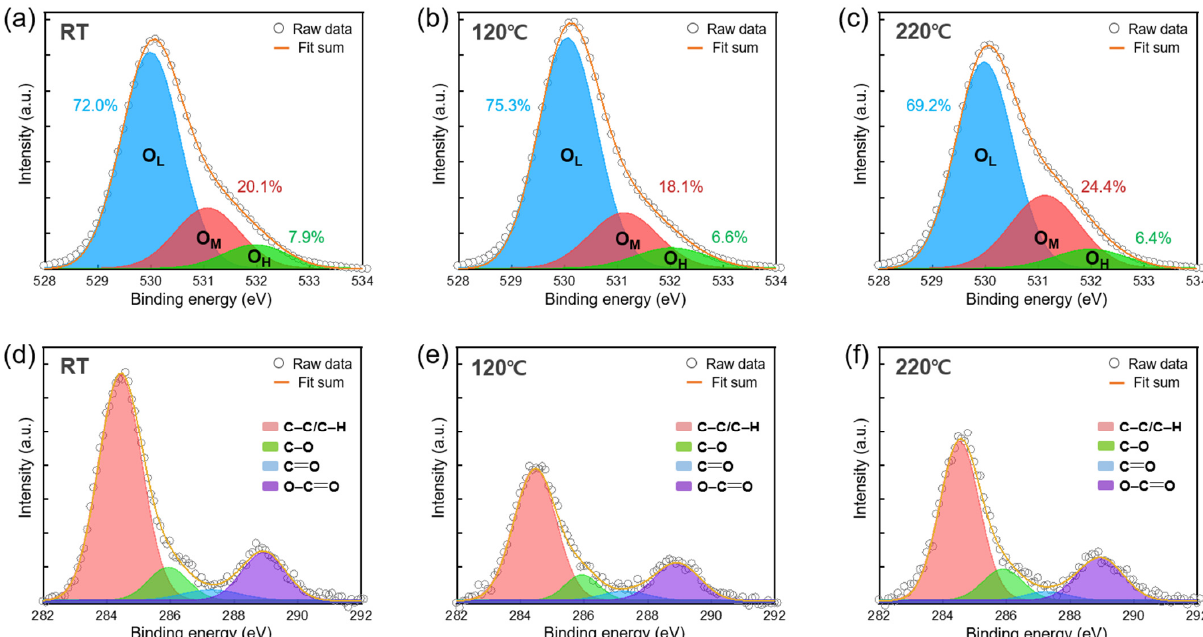
Figure 3. XPS O 1s peaks for the ZTO thin film pre–annealed at ( a ) RT, ( b ) 120 °C, and ( c ) 220 °C. XPS C 1s peaks for the ZTO thin film pre-annealed at ( d ) RT, ( e ) 120 °C, and ( f ) 220 °C.